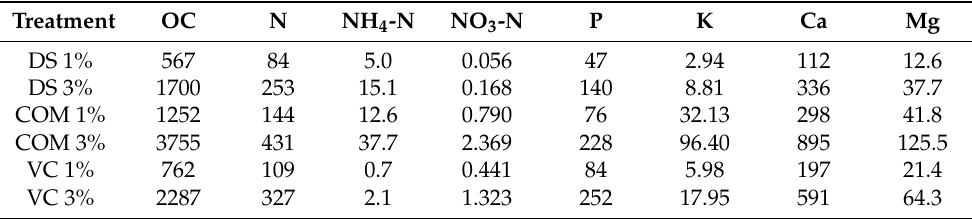
Clay % (>0.002 mm) * Dried at 105 ◦ C. Table 2. Calculated organic carbon, total and mineral N, and pseudo-total element loads in the digested sludge (DS), compost (COM), and vermicompost (VC) treatments (mg/kg soil).